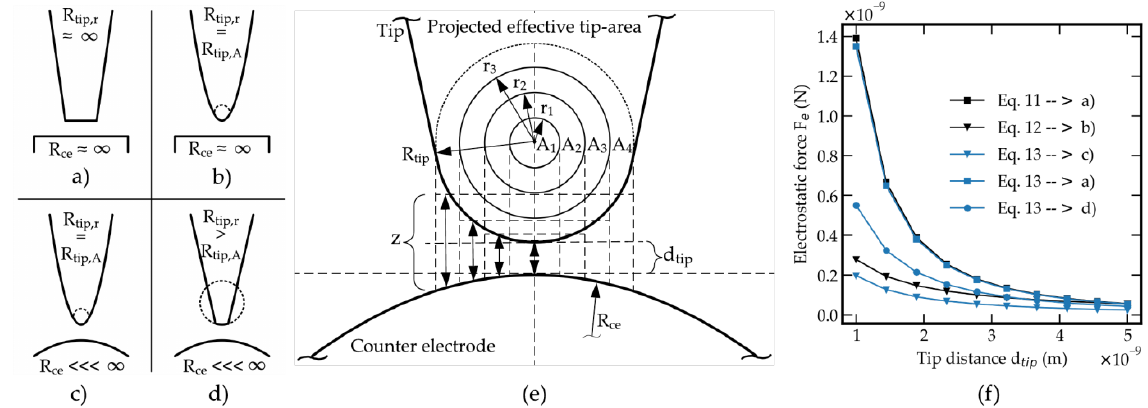
Figure 4. Analytical approach for the calculation of electrostatic force between tunneling electrodes. ( a – d ) Overview of possible tip–tip configurations. ( e ) Geometrical parameters of tip and counter electrode respectively configurations in ( c , d ). ( f ) Comparison of three calculation results for the plane–plane, the sphere–plane and modified equation for the sphere–sphere configuration. R tip , r = radius of the tip rounding, R tip , A = radius of the tip area, R ce = radius of the counter electrode, z = total effective distance of a subarea of the tip, d tip = the tip center